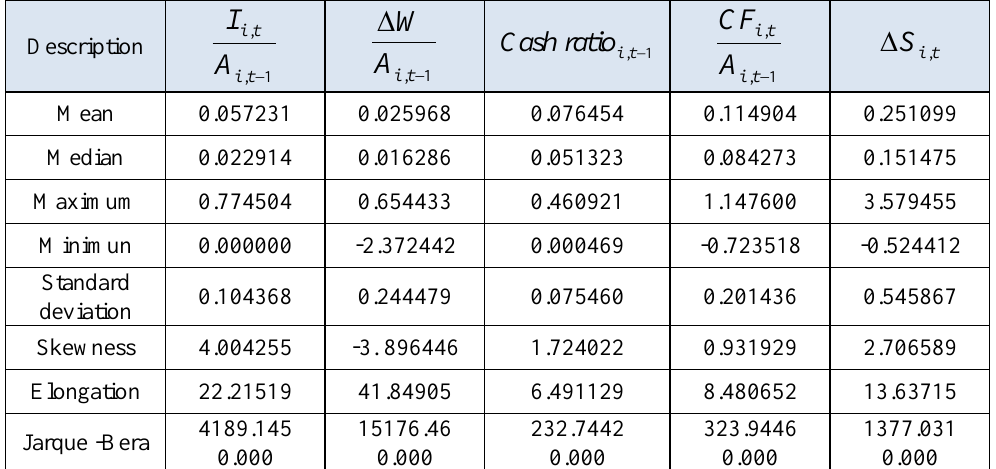
Table 1. Descriptive Statistics of the research